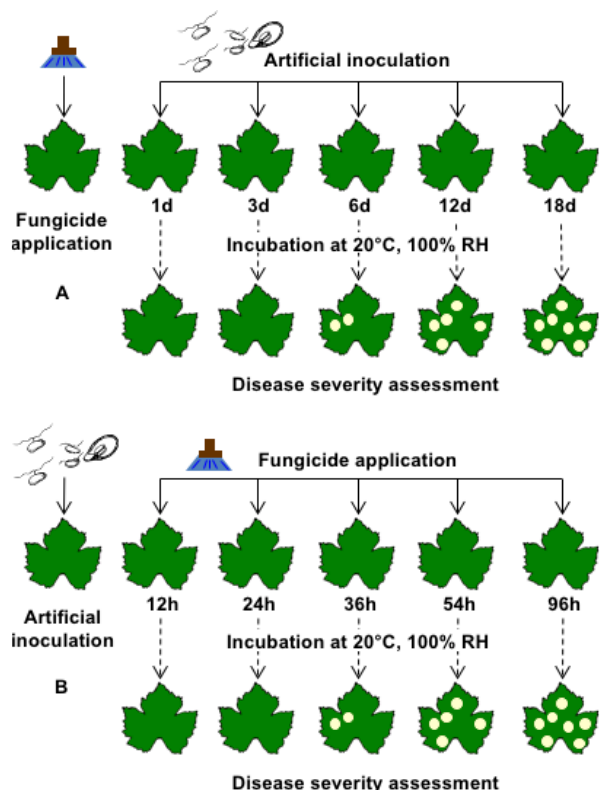
Figure 5. Examples of experiments used for the parameteri- sation of equation EF t = EF 0 / [1 + exp (a – b × C t )] [5], for Plasmopara viticola , the causal agent of grape downy mil- dew. In (A) (pre-inoculation activity), the fungicide is ap- plied to the leaves, and leaves are inoculated with a P. viti- cola sporangial suspension after 1, 3, 6, 12, or 18 d. the leaves are incubated at 20°C and 100% relative humidity until dis- ease develops and disease severity is assessed. In (B) (post- inoculation activity), leaves are artificially inoculated with a sporangial suspension, and the fungicide is applied 12, 24, 36, 54, or 96 h later. The leaves are then incubated as above before disease severity is